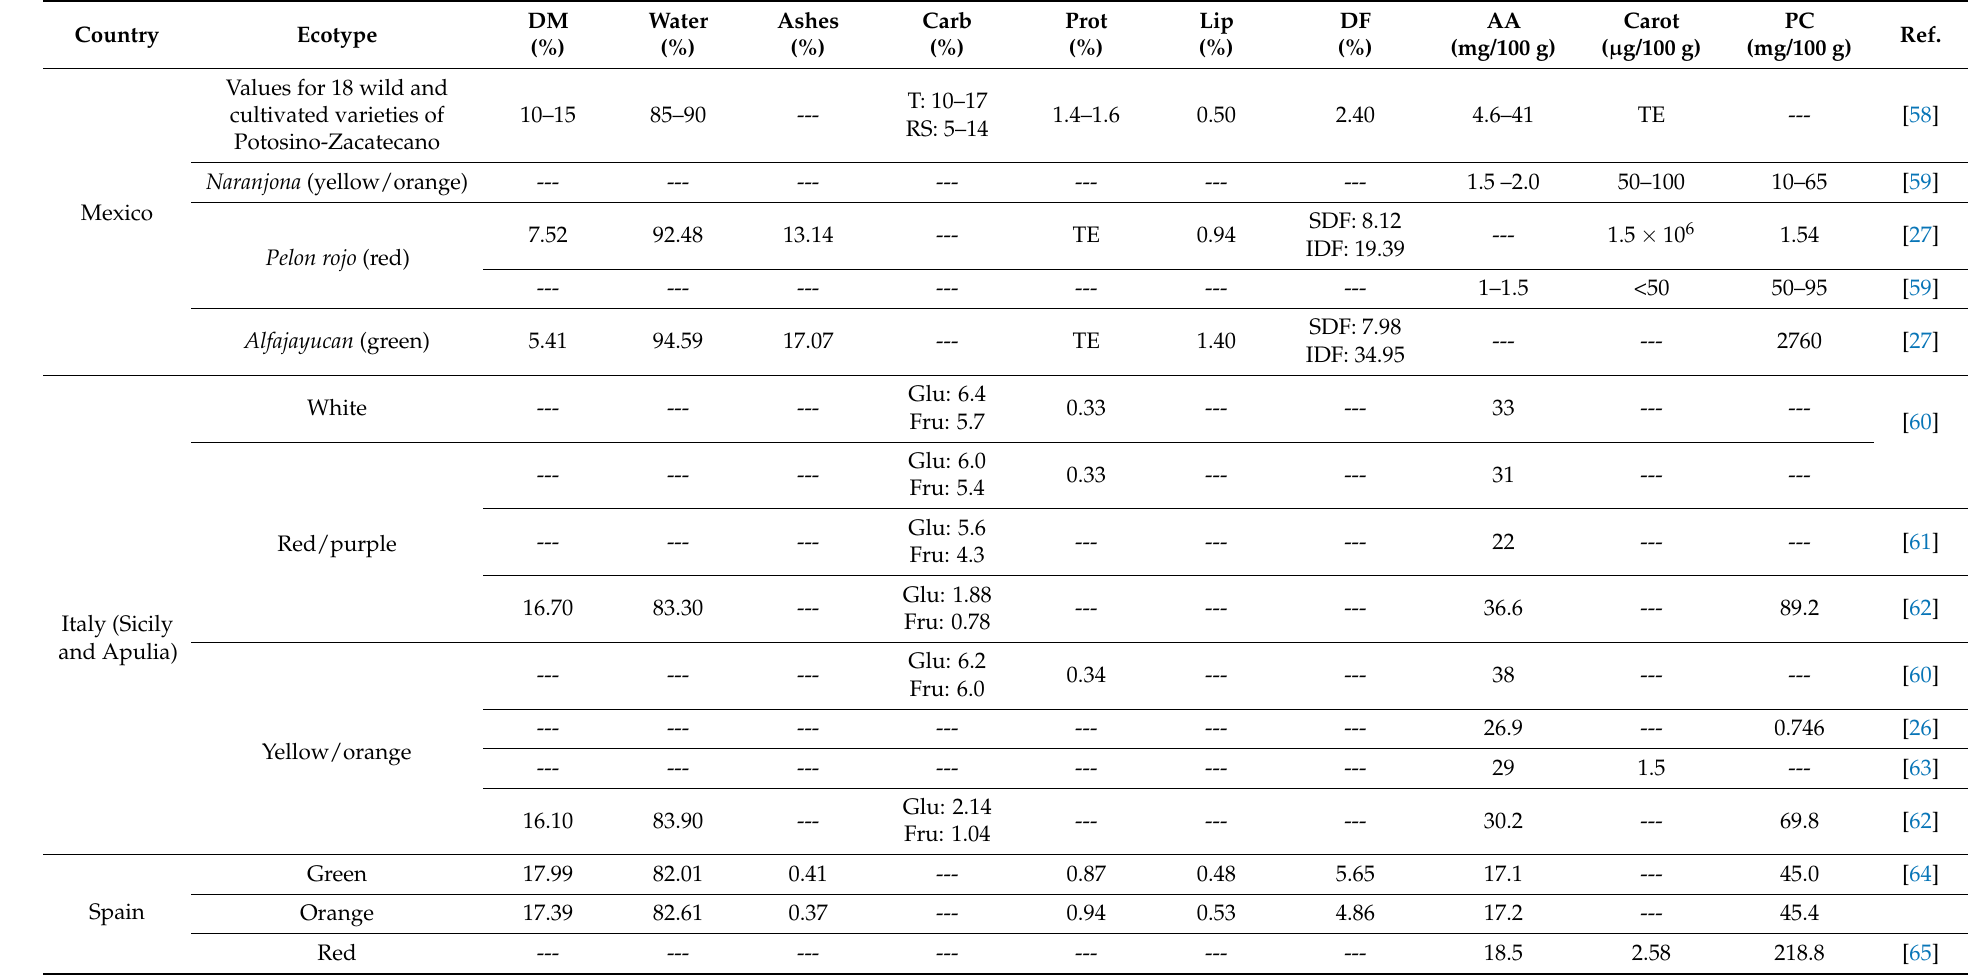
Table 2. Physicochemical and nutritional composition of several PP ecotypes in different regions of the